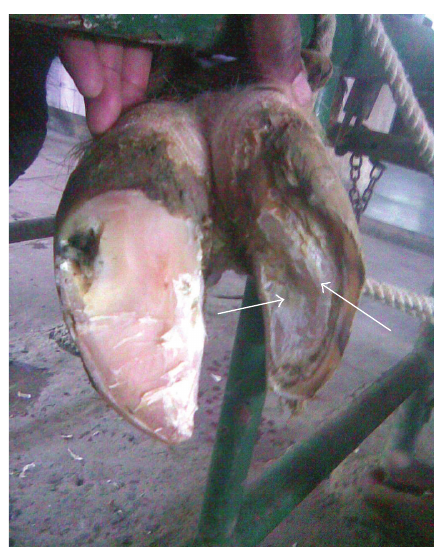
Figure 3: Sole avulsion.